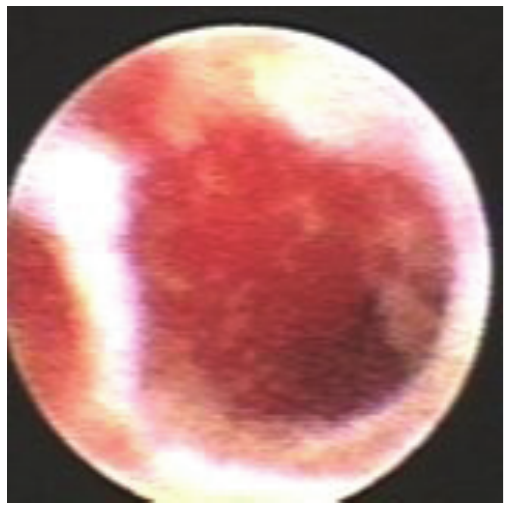
Figure 2: Appearances at mammary ductoscopy of